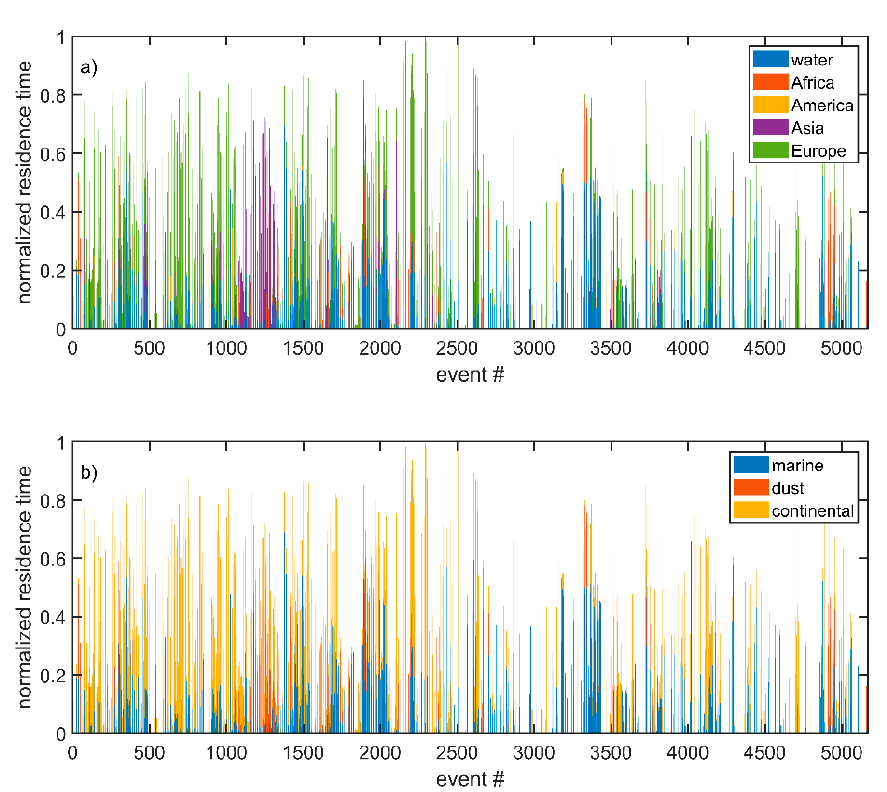
Figure A2. Normalized residence time over continents ( a ) and the associated aerosol type ( b ).